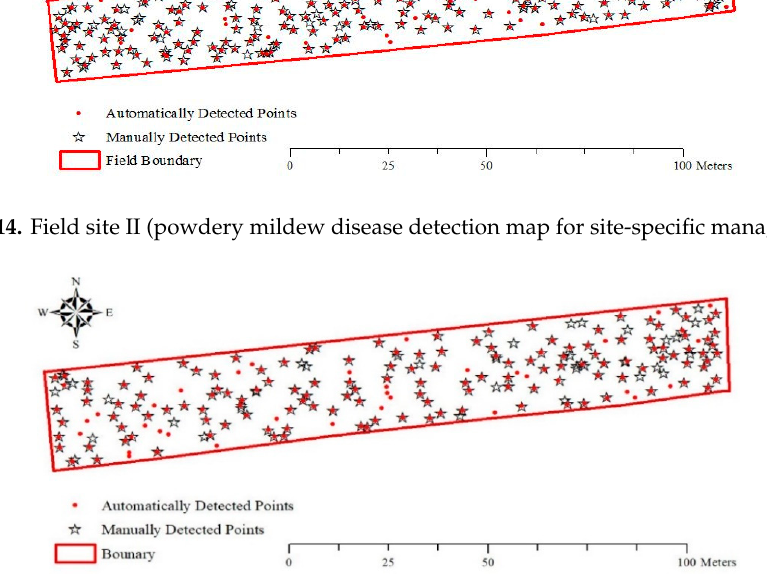
Figure 15. Field site III (powdery mildew disease detection map for site-specific